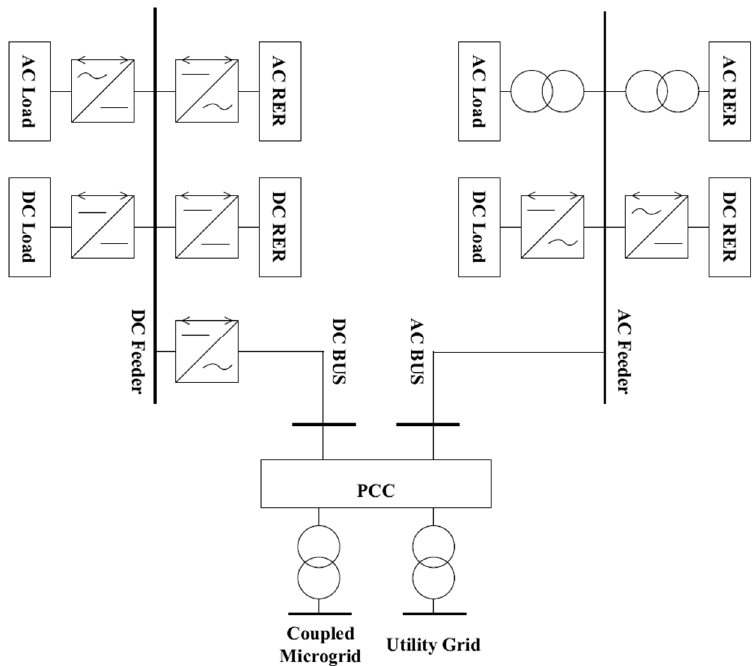
Figure 1. General configuration of hybrid provisional microgrids.